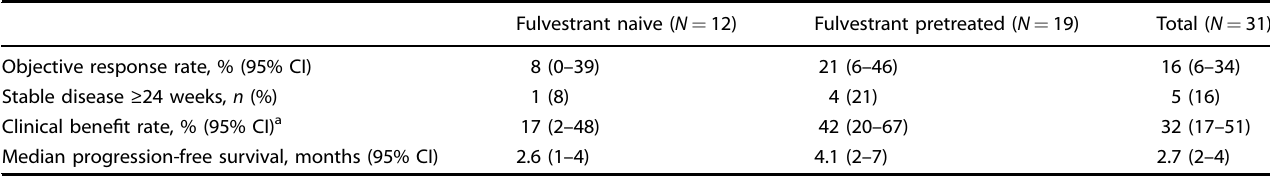
Table 2. Clinical ef fi cacy summary in patients with PTEN -mutant ER + MBC treated with capivasertib and